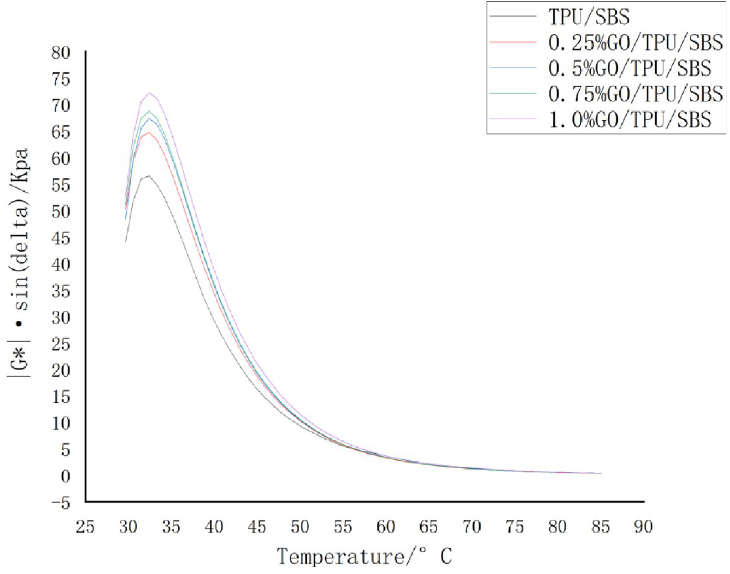
Fig 8. The variation of the G � sin δ values of the GO/TPU/SBS-modified asphalt with the temperature.